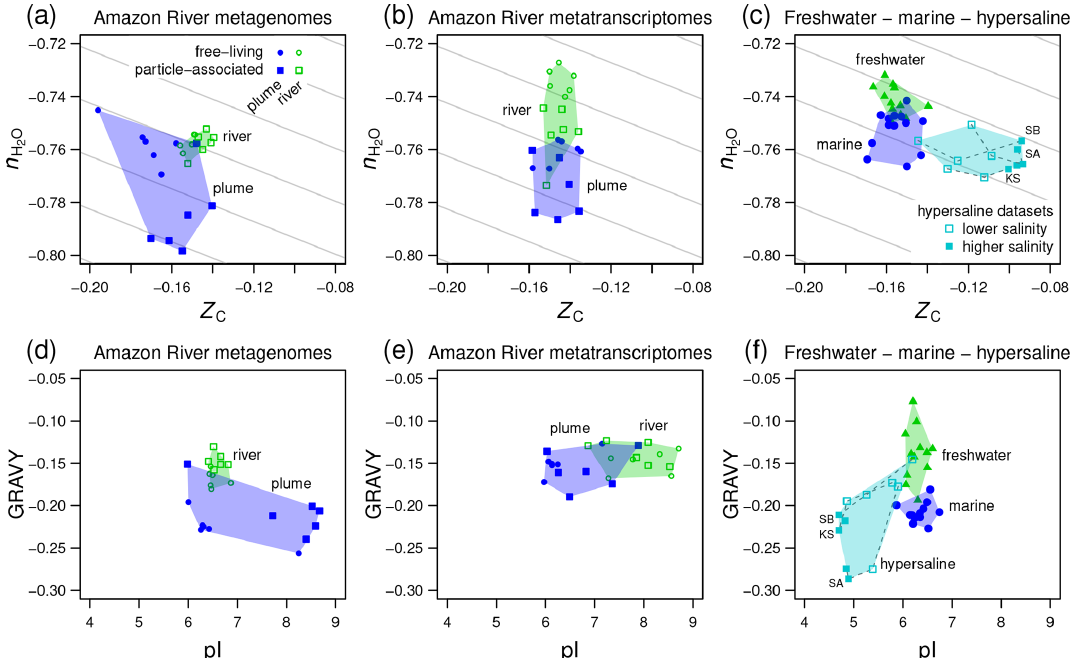
Figure 5. Compositional analysis and hydropathicity and isoelectric point calculations for proteins from the Amazon River and plume and other metagenomes. Samples representing freshwater, marine, and hypersaline environments are indicated by the colored convex hulls. (a) Metagenomic and (b) metatranscriptomic data for particle-associated and free-living fractions from the lower Amazon River (Satinsky et al., 2015) and plume in the Atlantic Ocean (Satinsky et al., 2014). (c) Freshwater (lakes in Sweden and USA) and marine metagenomes considered in a previous comparative study (Eiler et al., 2014) and metagenomes from hypersaline environments including Kulunda Steppe soda lakes in Siberia, Russia (Vavourakis et al., 2016) (KS), Santa Pola salterns in Spain (Ghai et al., 2011; Fernandez et al., 2013) (SA), and salterns in the South Bay of San Francisco, CA, USA (Kimbrel et al., 2018) (SB). Plots (d–f) show values of average hydropathicity (GRAVY) and isoelectric point (pI) of proteins for the same datasets. Background guidelines have slopes equal to that of the n H regression for amino acids in Fig.